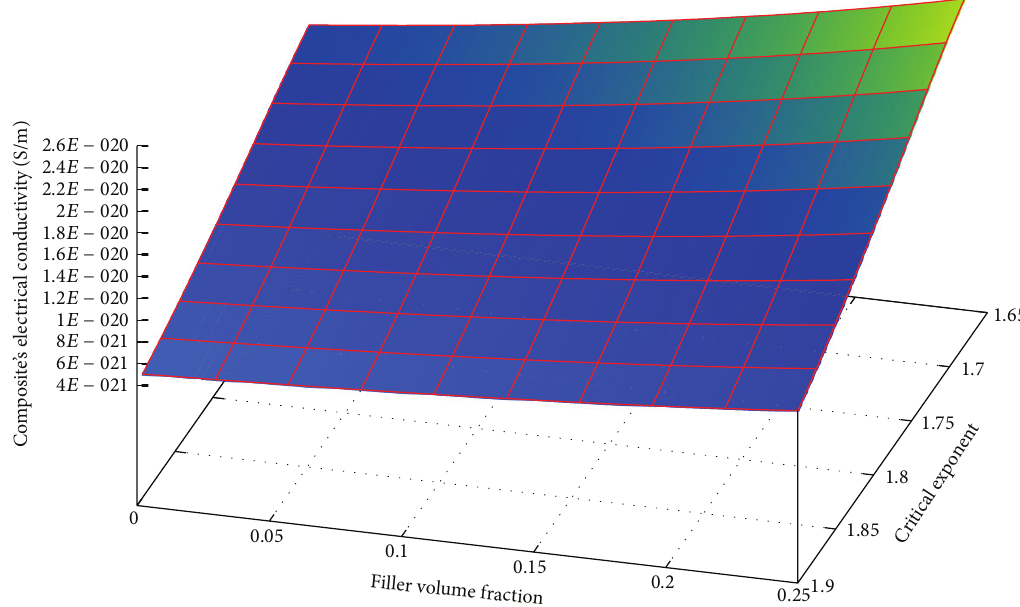
Figure 13: DC electrical conductivity of the nanocomposite at varying both the critical exponent of the percolation and the volume fraction of the filler (McLachlan’s model).